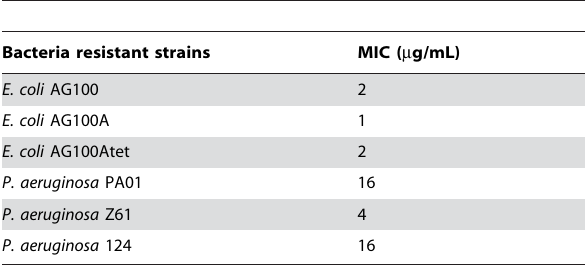
Table 2. Antimicrobial activities of squalamine 1 towards bacteria resistant strains.